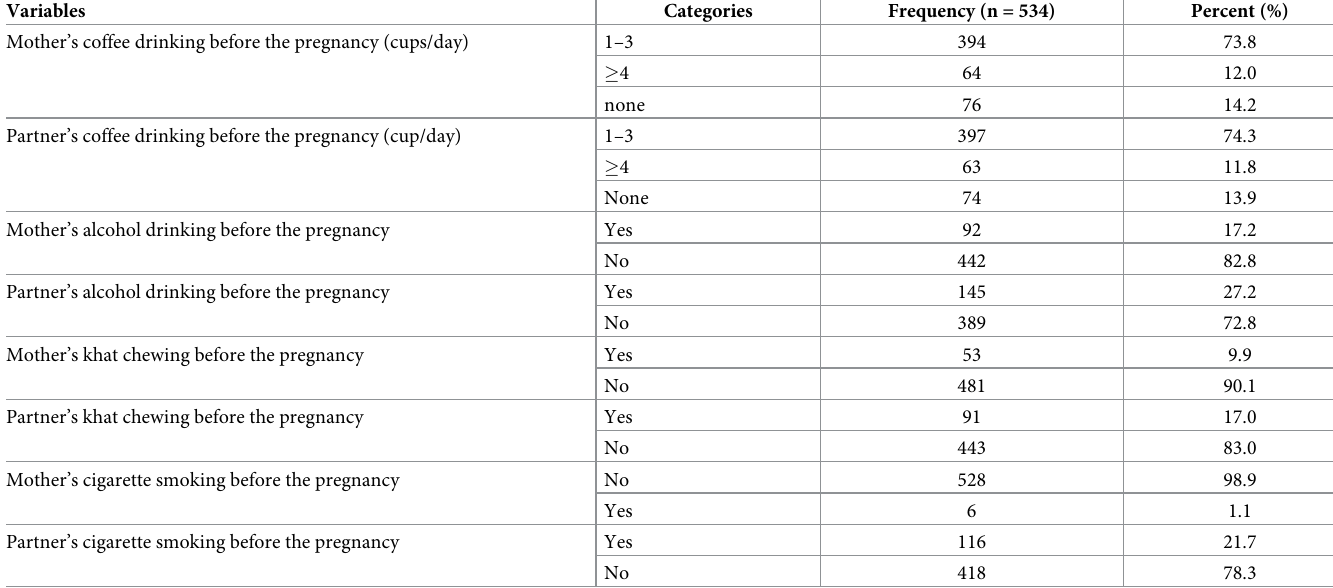
Table 2. Substances use related factors of mothers with natural planned conception attended ANC service at AMHFs and their partners, 2020. Variables